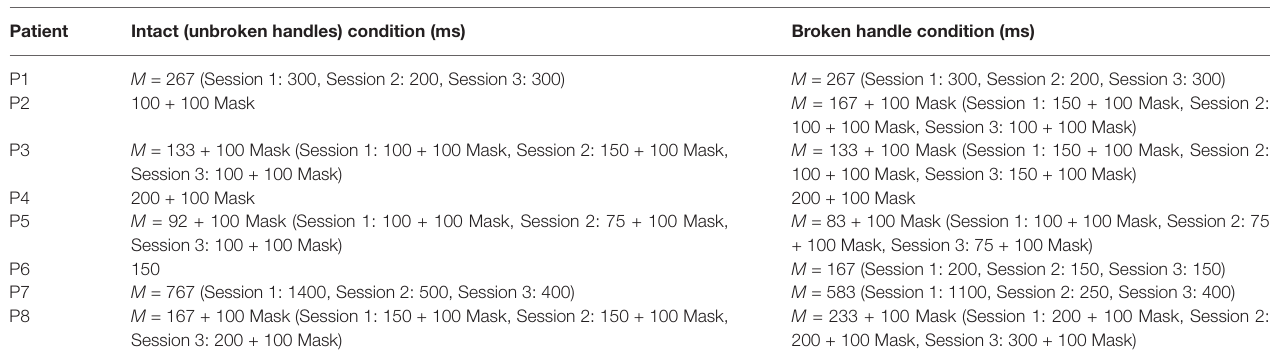
TABLE 2 | Stimulus exposure times for the Intact (unbroken handles) and the Broken handle